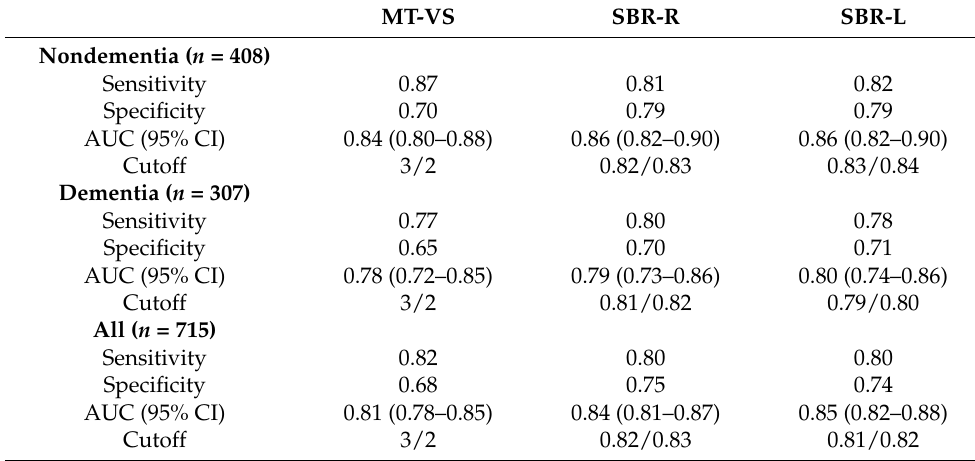
Table 3. Comparison of sensitivity, specificity, area under curve (AUC), and cutoff scores for the diagnosis of Lewy body disease (LBD) among the machine learning-visual scale (MT-VS) and striatal- background ratio (SBR) for Tc99m TRODAT-1.